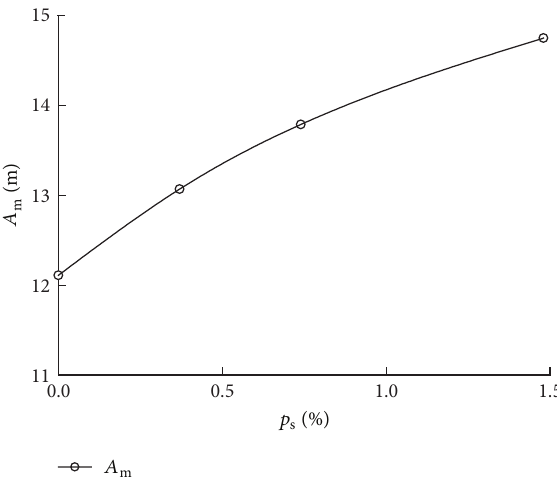
Figure 13: Pressure waves for various reinforcement ratios.